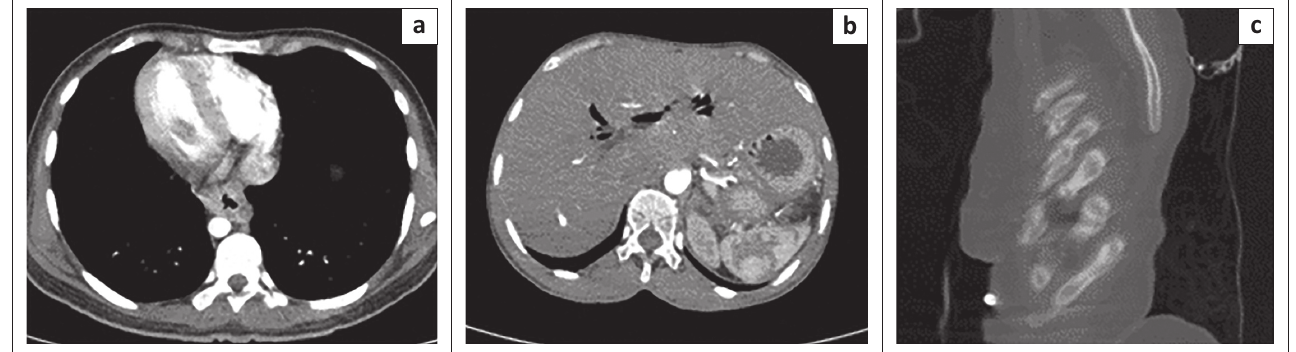
FIGURE 5 : Axial (a, b) and sagittal (c) CT images of incidental extra-pulmonary findings in three pulmonary embolism-negative patients. (a) A patient with circumferential lower oesophageal wall thickening, (b) extensive pneumobilia in a post-surgical patient and (c) patient with multiple chronic rib fractures.